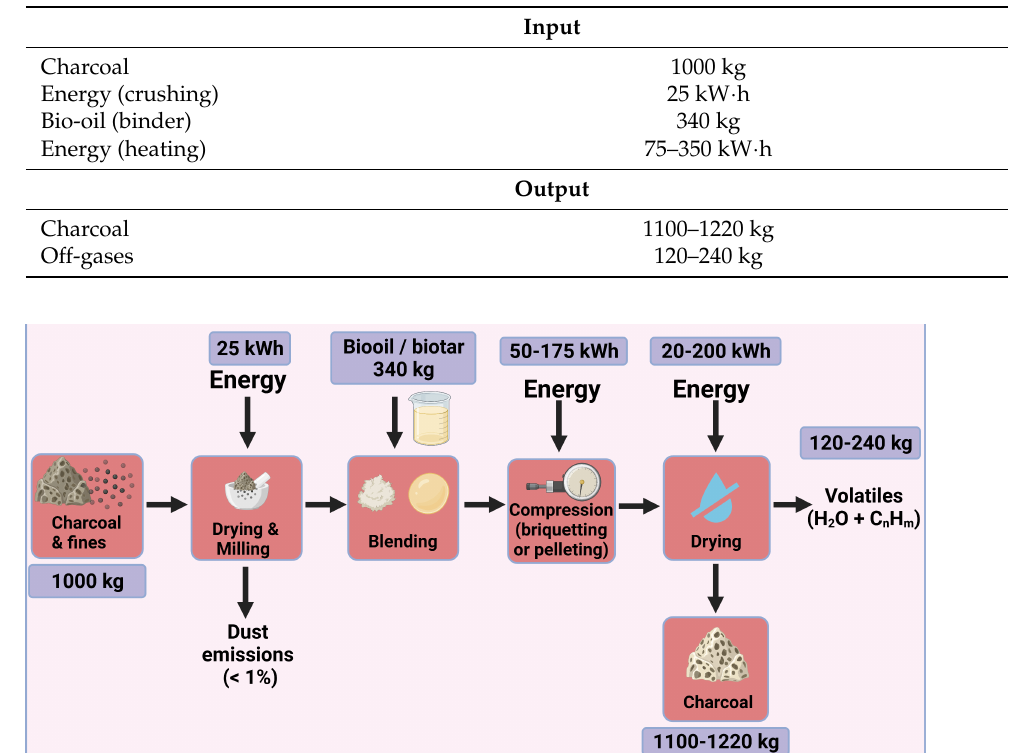
Figure 3. Flowsheet of charcoal briquetting with bio-oil